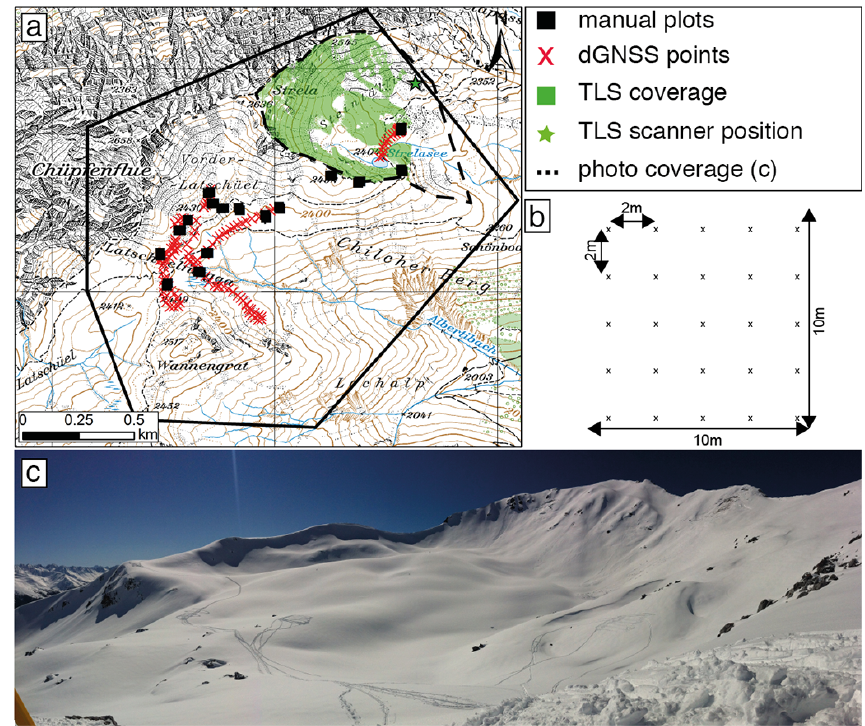
Figure 2. Map (a) of the locations of the plots measured by hand, the dGNSS measurements, the TLS coverage and the coverage of the panorama photograph; applied sampling strategy for the manual plots (b) ; panorama photograph of the Wannengrat test site (c) . Pixmap © 2014 swisstopo